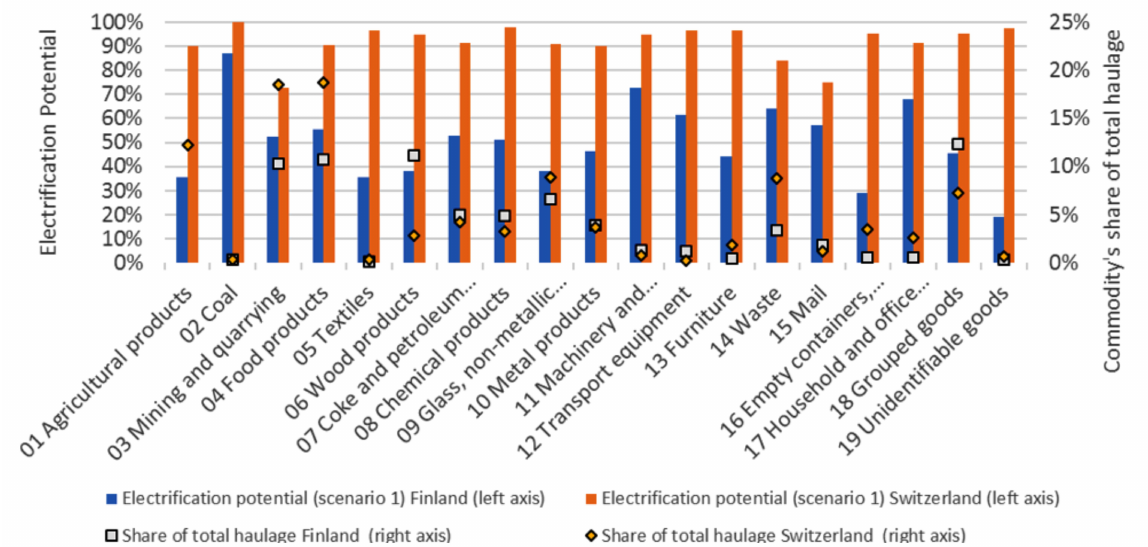
Figure 5. Comparative graph of the manageable successful trip outcomes for the share of total haulage (tkm) and elec- trification potential (% of tkm) of various commodities based on the current technology scenario (scenario 1) in Finland and